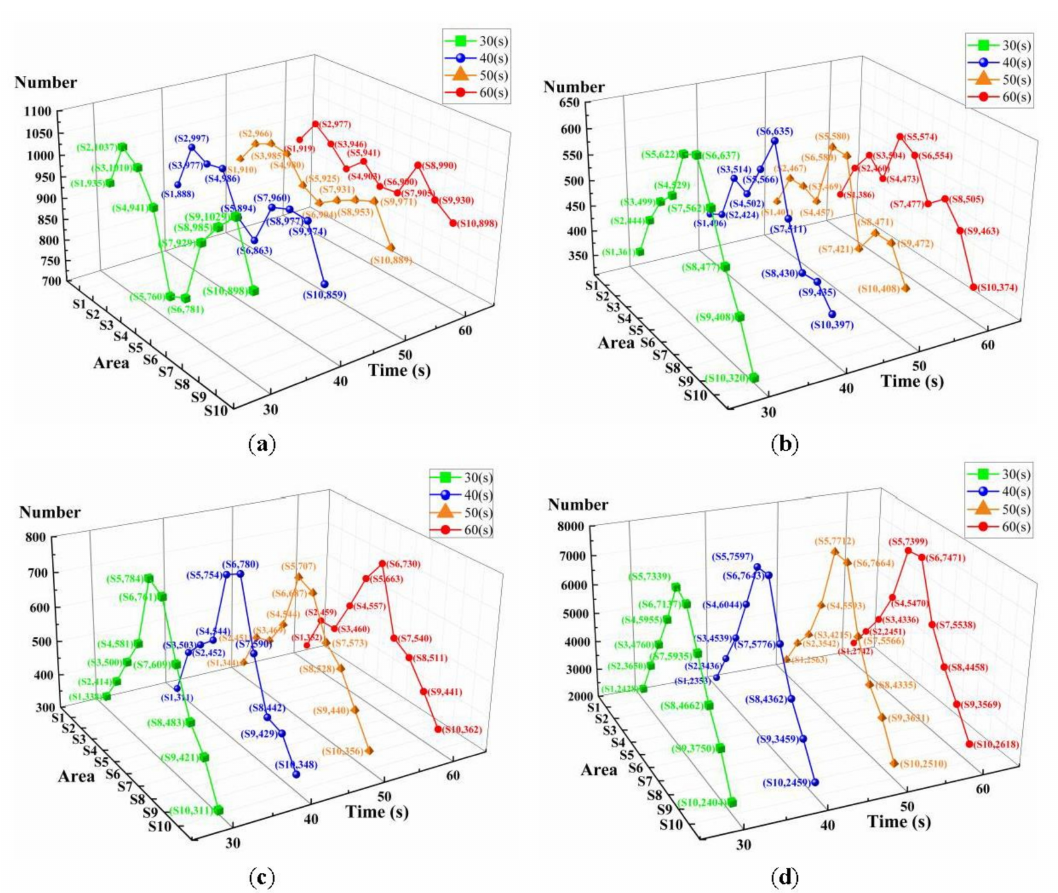
Figure 9. ( a ) The number of 180 mm rocks distributed in each area at each time point. ( b ) The number of 90 mm steel balls distributed in each area at each time point. ( c ) The number of 70 mm steel balls distributed in each area at each time point. ( d ) The number of 60 mm rocks distributed in each area at each time